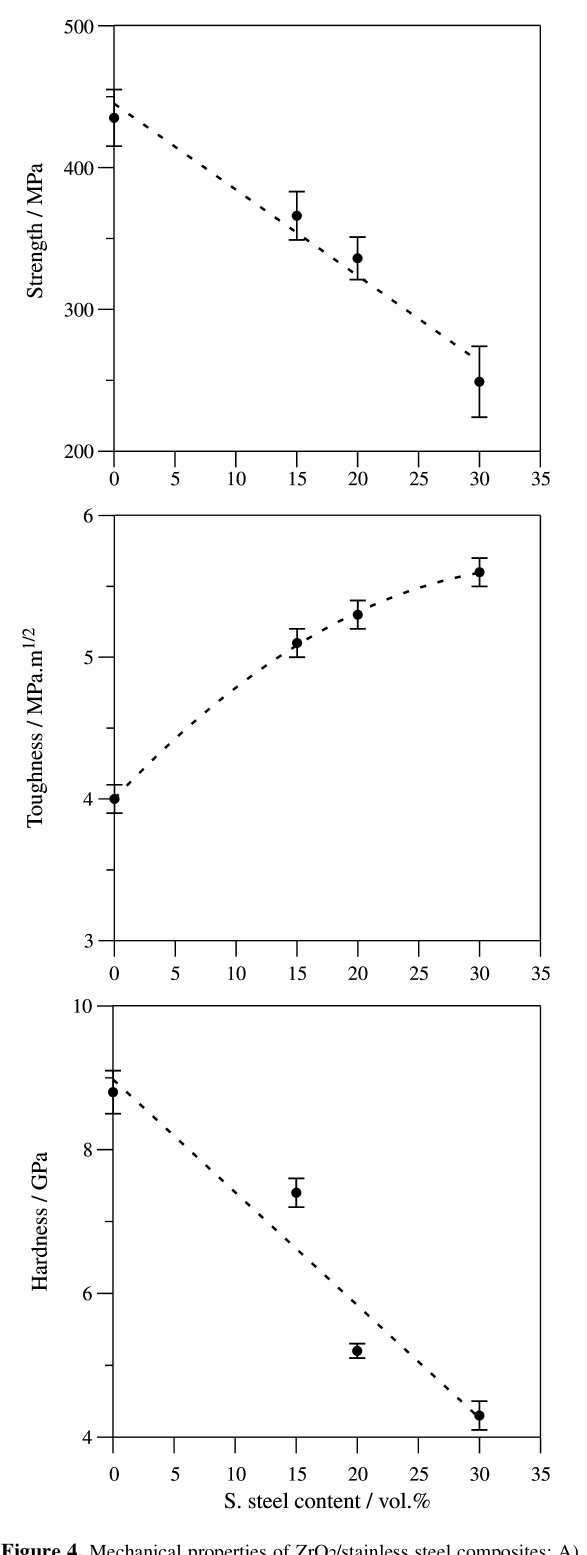
Figure 4. Mechanical properties of ZrO 2 /stainless steel composites: A) Bending strength, B) fracture toughness and C) Vickers hardness. The dashed lines are guides to the